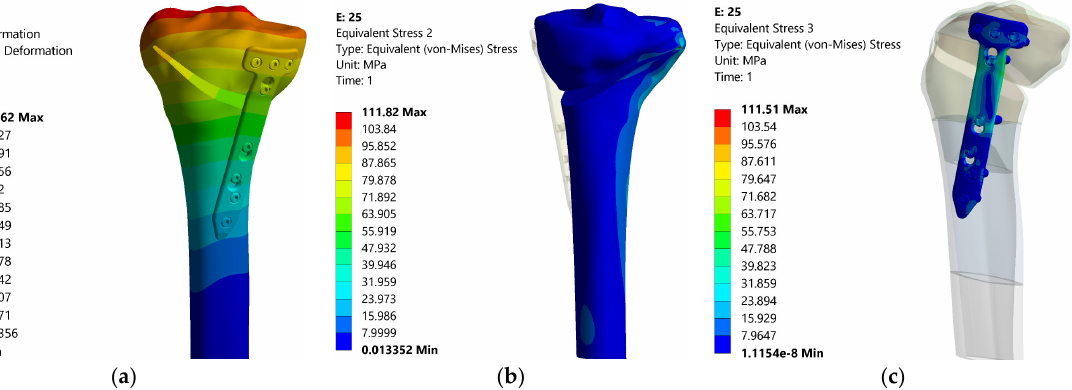
Figure 14. Distributions of the total deformation, equivalent stress in tibia and equivalent stress in the plate—12.5%.